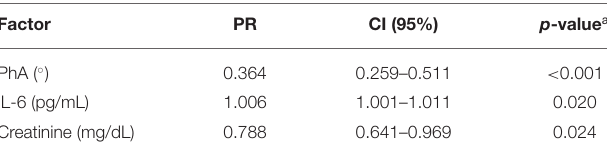
TABLE 4 | Multivariate poisson model derived prevalence ratio for sarcopenia by phase angle, interleukin six and creatinine. Factor PR CI (95%) p -value